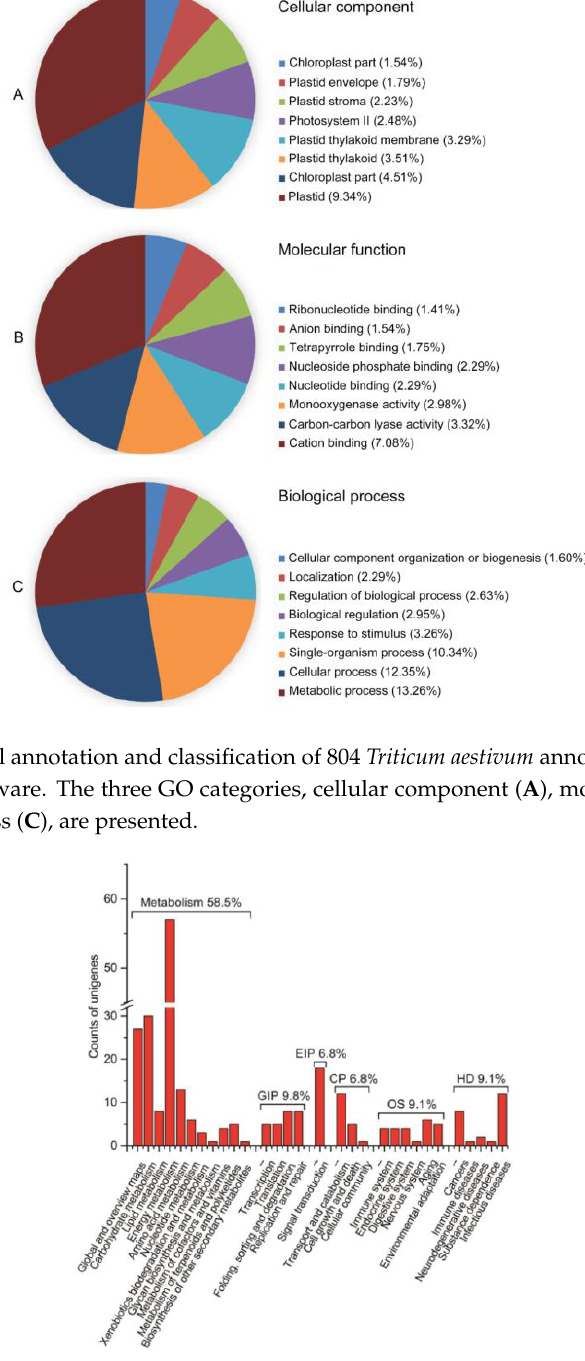
Figure 11. Functional annotation and classification of 804 Triticum aestivum annotated UniESTs using the KEGG pathway.